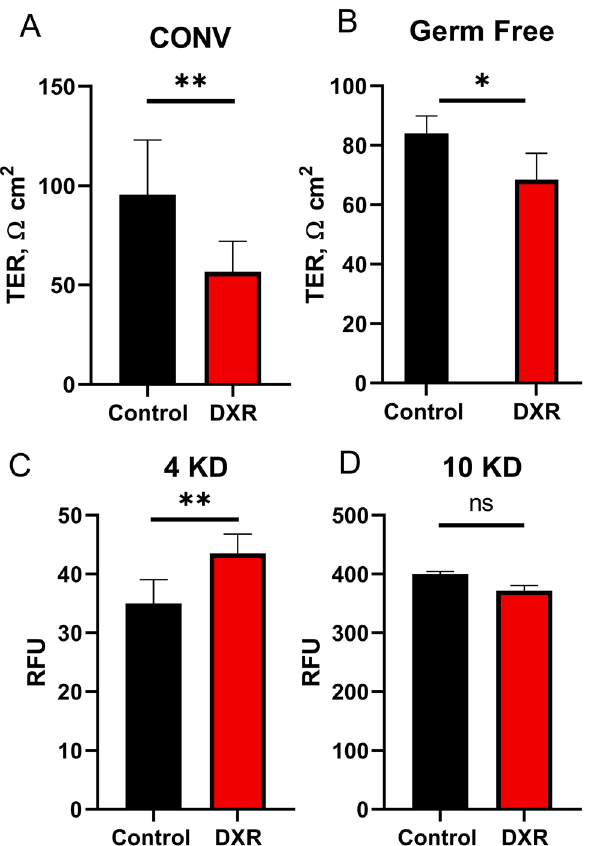
Figure 4. Doxorubicin in vivo increases permeability to small molecules in mouse jejunum. ( A ) TER measurements of conventionally raised (CONV) animals ( n = 3/group). ( B ) TER measurements of germ free (GF) animals ( n = 3/group). ( C , D ) Macromolecular flux measurements of jejunal tissue isolated from CONV mice ( n = 4/group). FITC-Dextran molecules of 4 kDa ( C ) and 10 kDa ( D ) were applied to the mucosal side at 24 h post-DXR (40 µg/mL), and the fluorescence of the serosal chamber was measured after flux. Student’s t -test; *p < 0.05; **p < 0.01; ns no